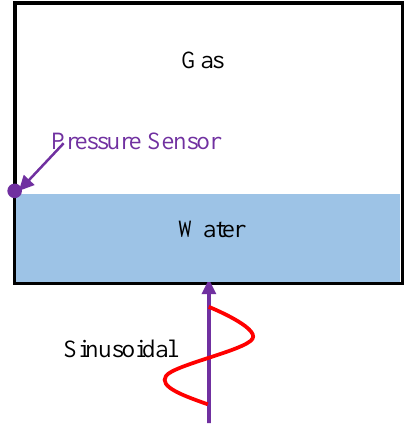
Figure 5. Schematic diagram of a sloshing rectangular water tank.